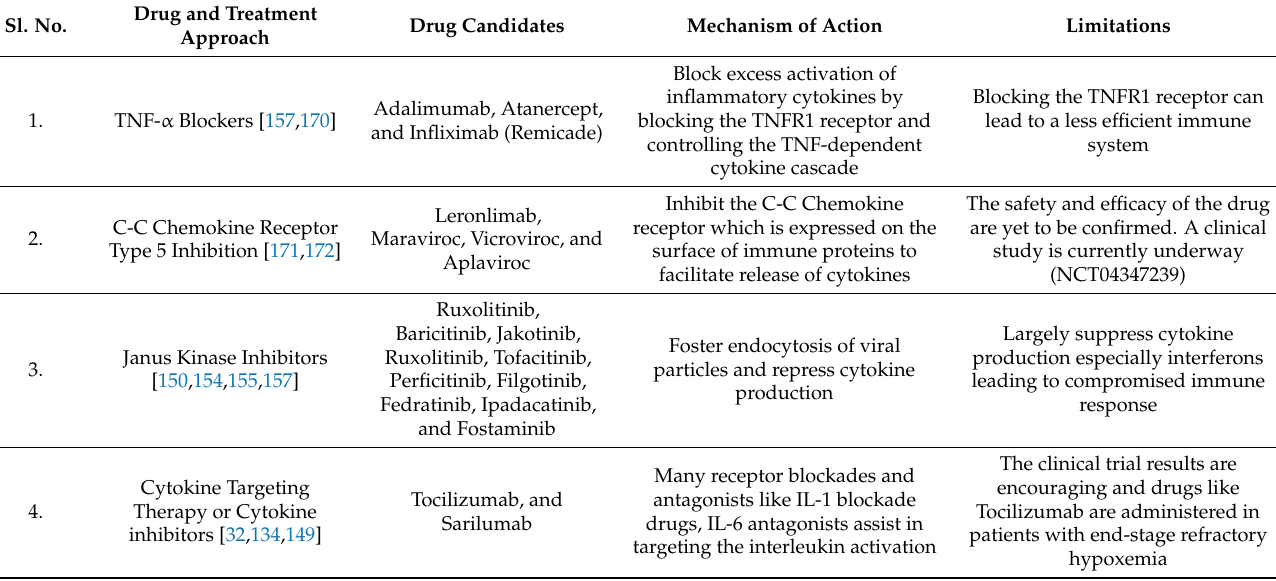
Table 2. Potential immunotherapeutic drug candidates to treat COVID-19 patients. Sl.